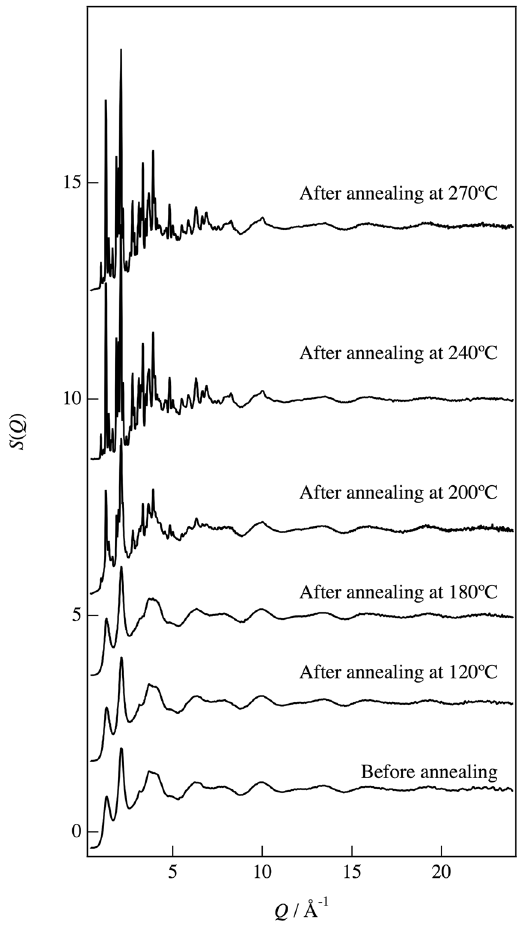
Figure 2. Total structure factors, S ( Q ), for the 75Li 2 S-25P 2 S 5 glasses obtained from X-ray diffraction before annealing and after annealing at 120 °C, 180 °C, 200 °C, 240 °C, and 270